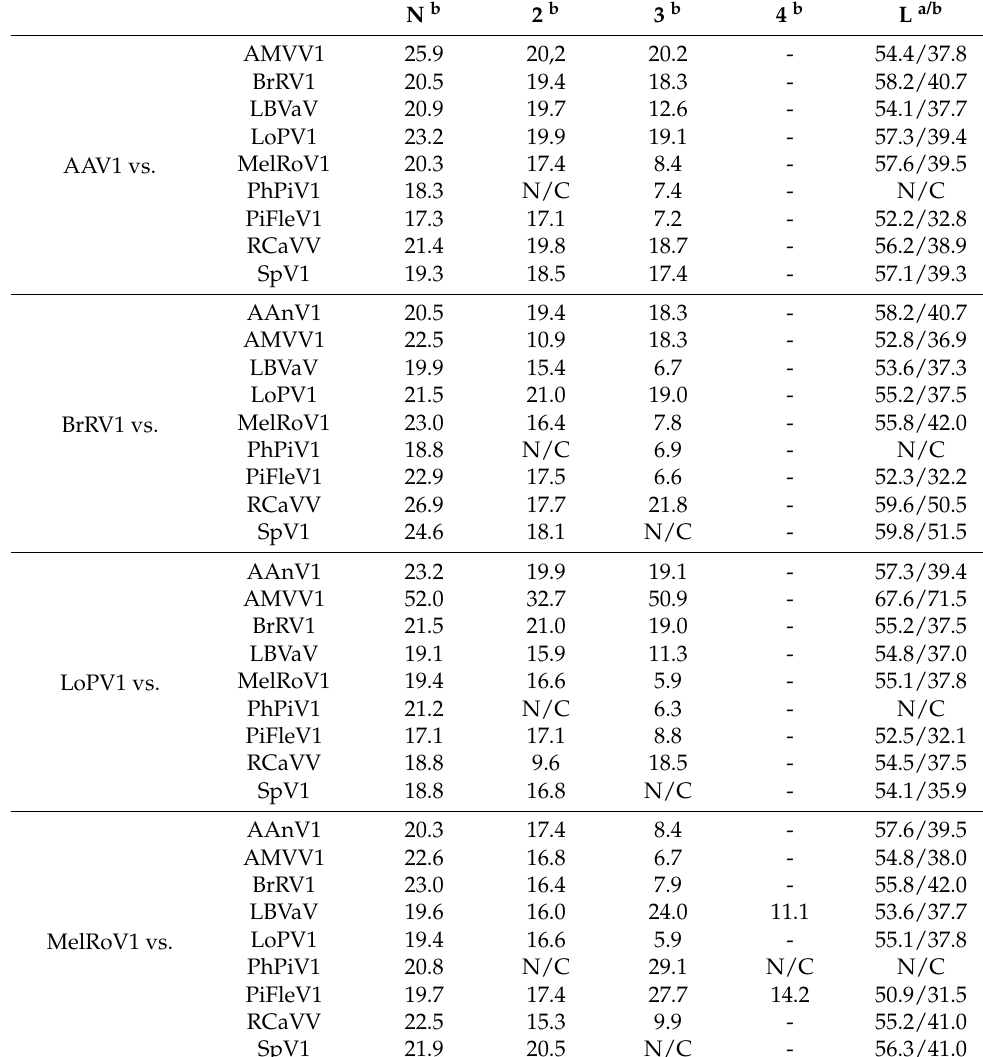
Table 7. Pairwise identity percentages between the varicosaviruses assembled in this study and the reported varicosaviruses.